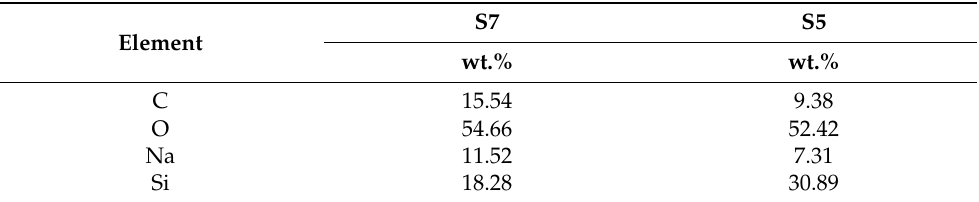
Table 10. EDX result of samples S7 and S5 before fire-retardant test.